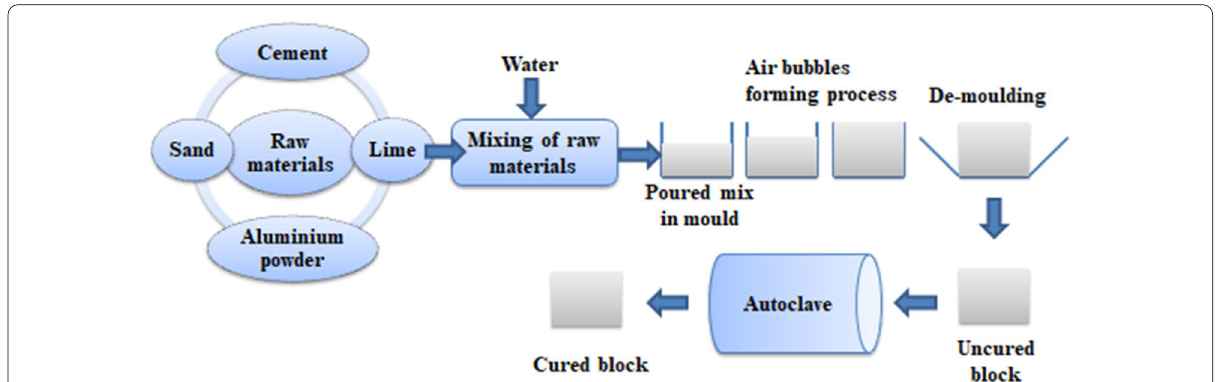
Fig. 6 Methodology adopted for development of AAC (Hamad, 2014)